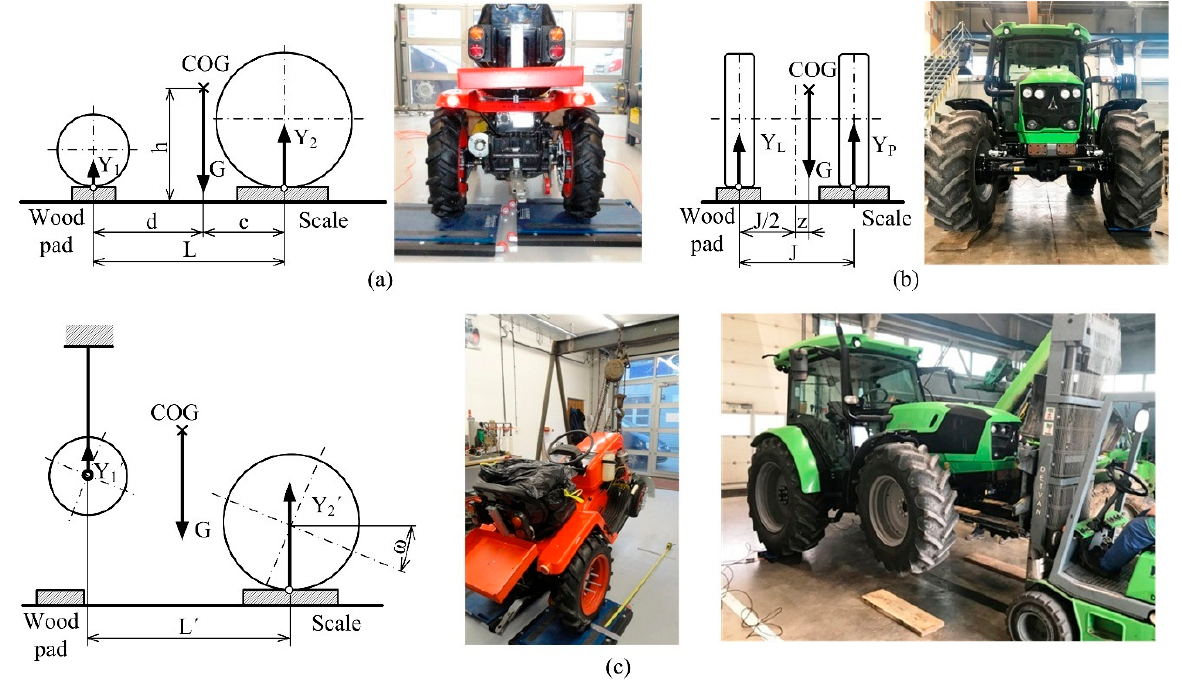
Figure 5. Experimental determination of COG coordinates: ( a ) Longitudinal coordinates of COG and rear axle weighting; ( b ) Calculation of lateral position of COG and left side weighting; ( c ) Lifted front axle: L —wheelbase; c, d —longitudinal coordinates of COG; h —vertical coordinate of COG; J —tread width; z —lateral position of COG; G —tractor weight; Y 1 , Y 2 , Y P , Y L ,—ground reactions; ω —lifting angle; L’ —vertical projection of wheelbase; Y 1 ’ , Y 2 ’ —reaction when the tractor is in raised position.